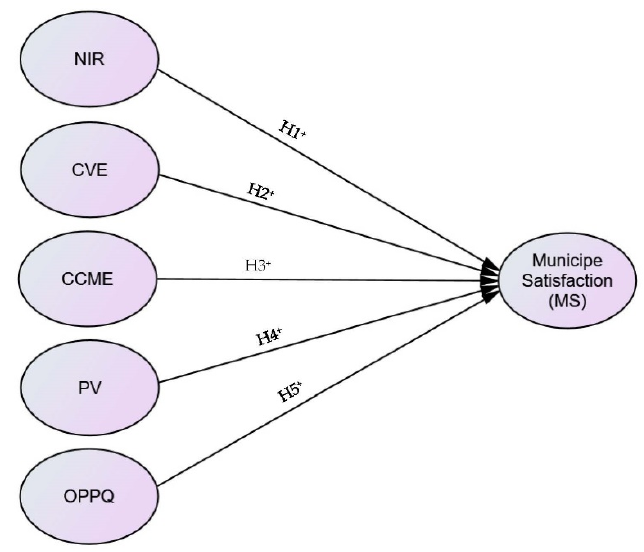
Figure 1. Research